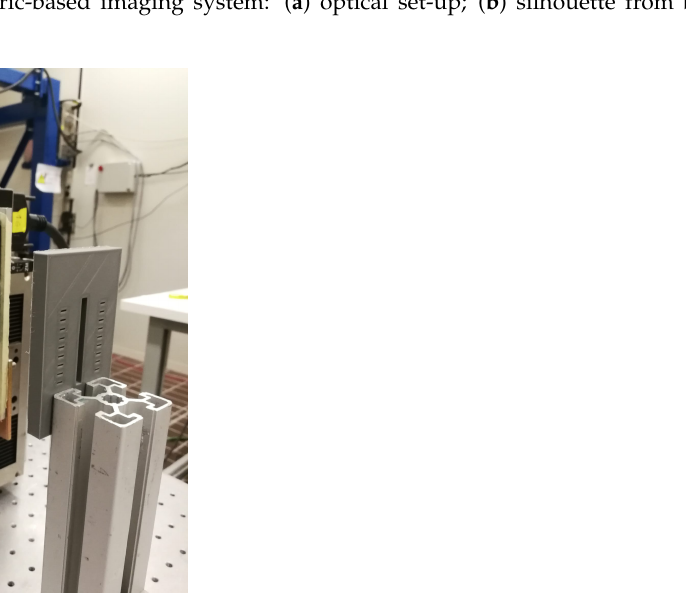
Figure 26. Test set-up of the Wenglor MLSL132 laser profilometer used to evaluate the value of the reference groove